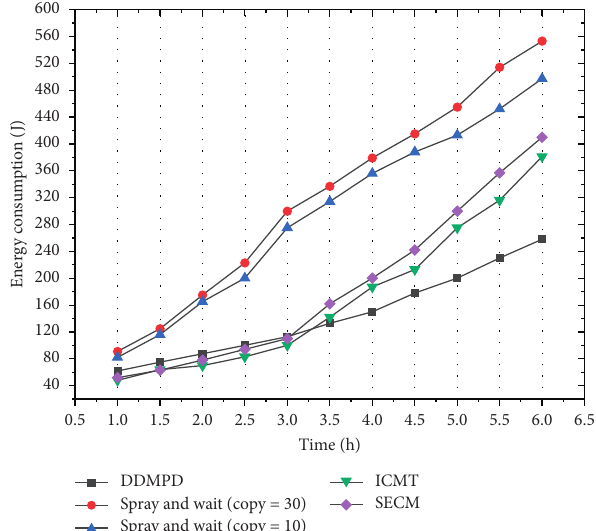
Figure 9: Relationship between energy consumption and time.